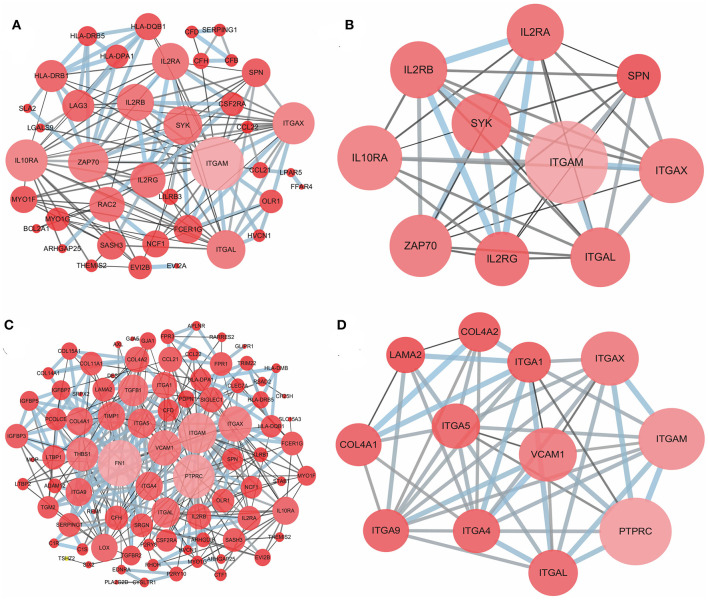
PPI network of common DEGs for the immune and stromal score groups. (A) PPI network of 54 DEGs in the immune score group; (B) ITGAM module, top 1 PPI network for the immune score group, identified by Cytoscape MCODE; (C) PPI network of 116 DEGs in the stromal score group; (D) PTPRC module, top 1 PPI network for the stromal score group.